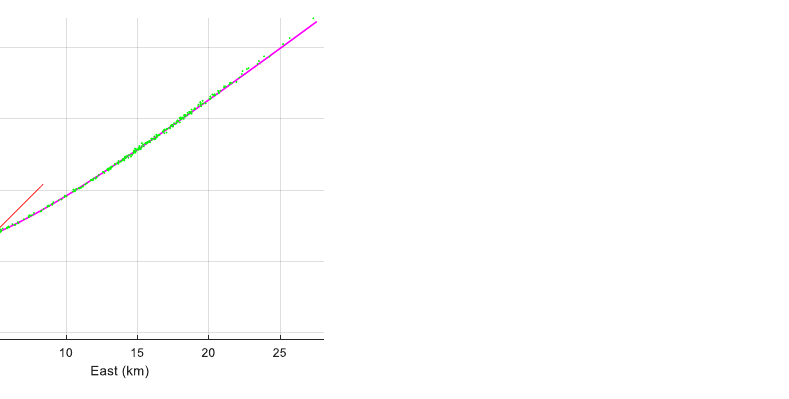
Figure 4. The cloud of estimated position (in green), a piece of the hyperbola (intersection of the cone of ambiguity and the plane 𝑧 = 𝑧 𝐴𝑠 (= 200 m) , for 𝜎 = 1.7 × 10 −2 . Table 1. Performance of the estimator of the reduced state vector when 𝜎 = 1.7 × 10 −2 , in terms of bias, sample standard deviation and the one given by the square root of the di- agonal of the CRLB. Table 2. Performance of the estimator of the reduced state vector with σ = 1.7 × 10 − 4 . X r